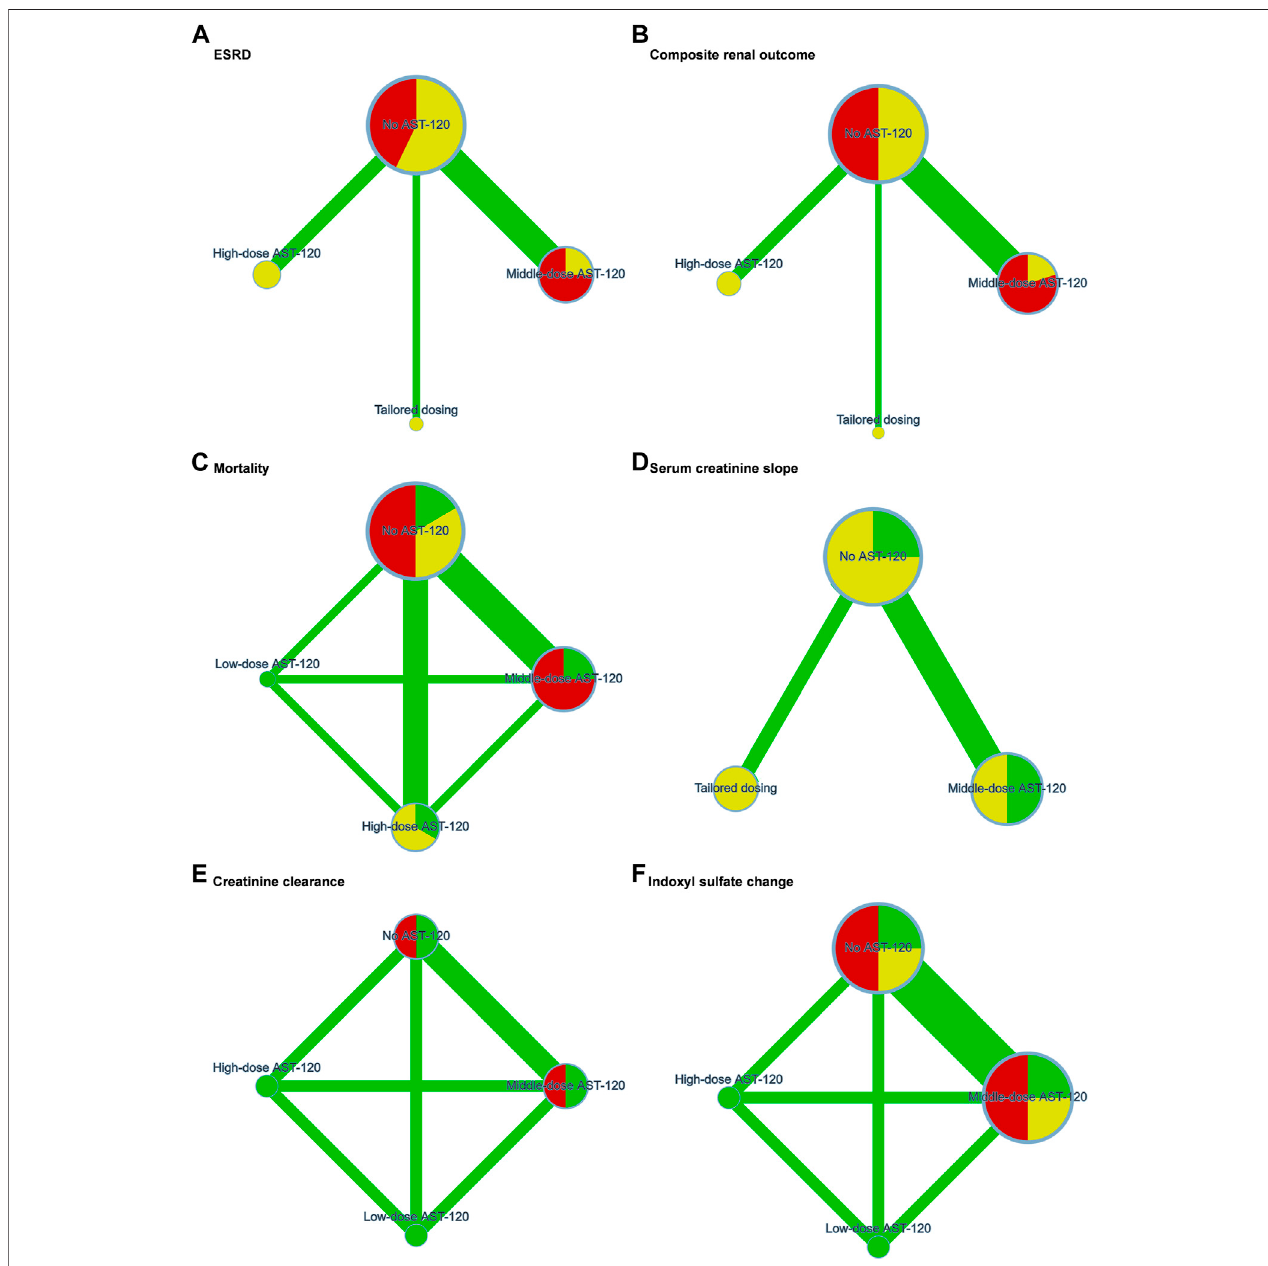
FIGURE 2 | Network plots of (A) end stage renal disease, (B) composite renal outcome, (C) mortality, (D) serum creatinine slope, (E) creatinine clearance, and (F) indoxyl sulfate change. ESRD, end stage renal disease. Green, yellow, and red refers to low risk, some concerns, and high risk of bias respectively.